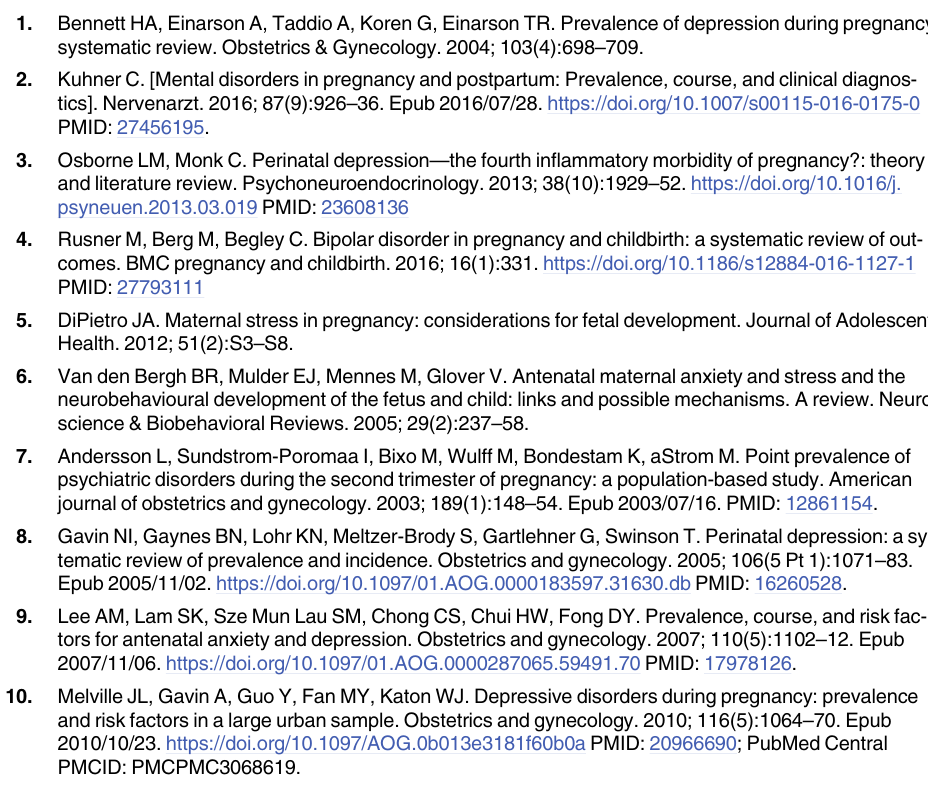
S1 Table. PRISMA-P (Preferred Reporting Items for Systematic review and Meta-Analysis Protocols) 2015 checklist: Recommended items addressed in our systematic review and meta-analysis. S2 Table. Summary of quality assessment and agreed level of bias and level of agreement on the methodological qualities of included studies in meta-analysis based on sampling, outcome, response rate and method of